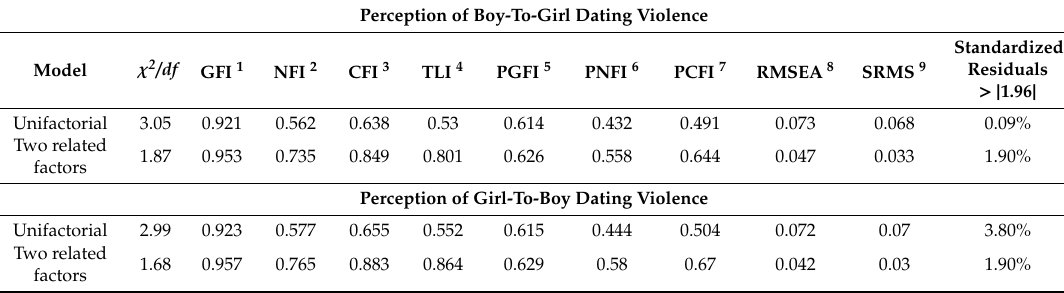
Table 3. Goodness-of-fit for the contrasted models.